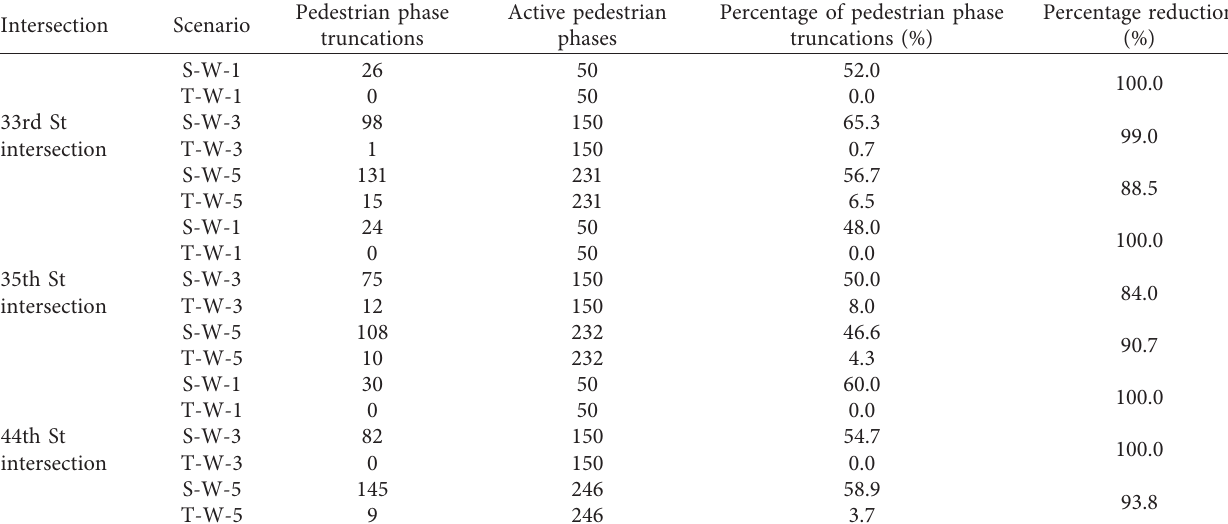
Table 5: Pedestrian phase cutoffs for the scenarios with WB